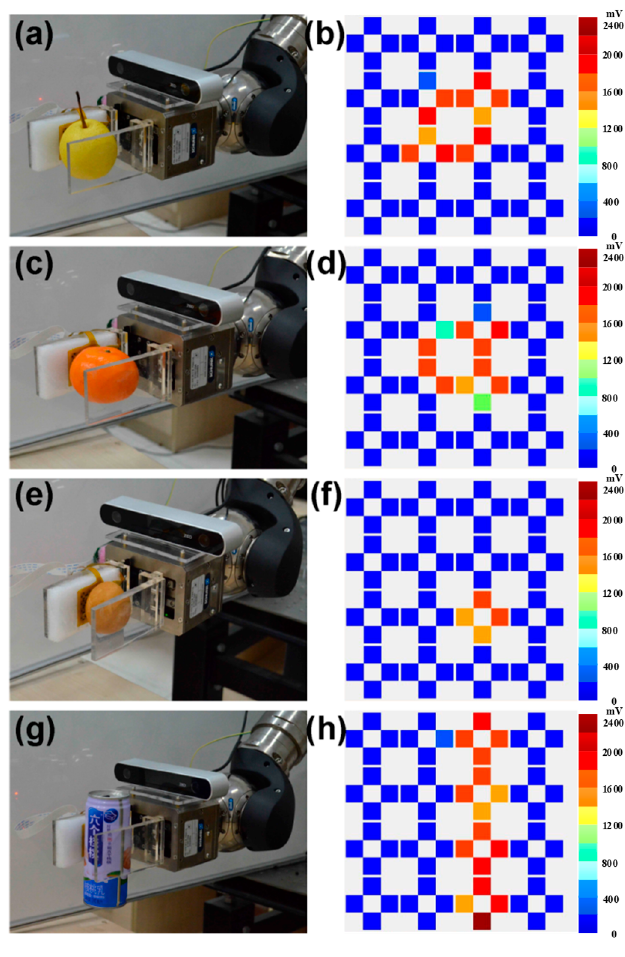
Figure 8. Robot arm grasps different objects by clamps and corresponding pressure distribution diagram: ( a , b ) pear, ( c , d ) orange, ( e , f ) egg, ( g , h ) pop-top can. diagram: ( a , b ) pear, ( c , d ) orange, ( e , f ) egg, ( g , h ) pop-top